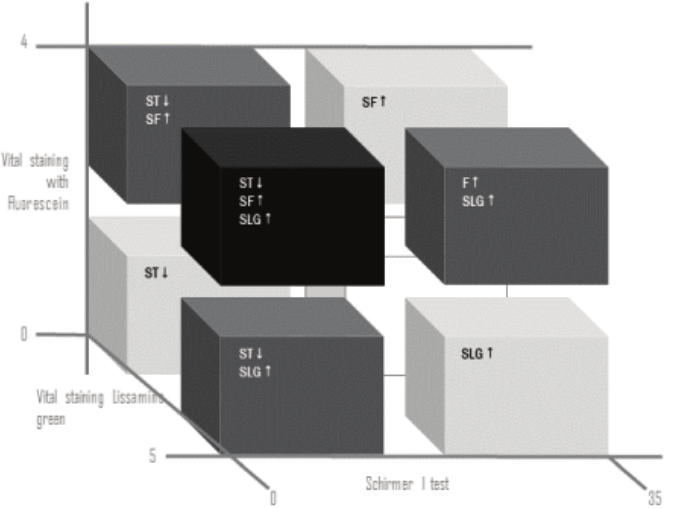
Figure 3. Projection of variables that separate populations with different levels of particulate matter (PM). SF, Vital staining with fluorescein; SLG, Vital staining with lissamine green; and ST, Schirmer test I. The black cube represents the population that exhibits alteration of all three variables, while the white cube represents the population that does not present any alteration of these variables. The cut-off values of each variable were SF: 3; SLG: 3; and ST: 10